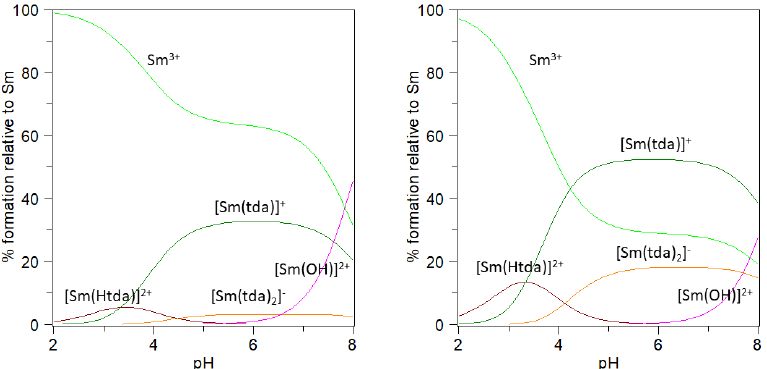
Figure 1. Species distribution diagram of the Sm-tda system at 25.0 °C, I = 0.15 mol·L −1 NaClO 4 . Left: total [Sm 3+ ] = 1 mM and total [tda] = 1 mM. Right: total [Sm 3+ ] = 1 mM and total [tda] = 3 mM.